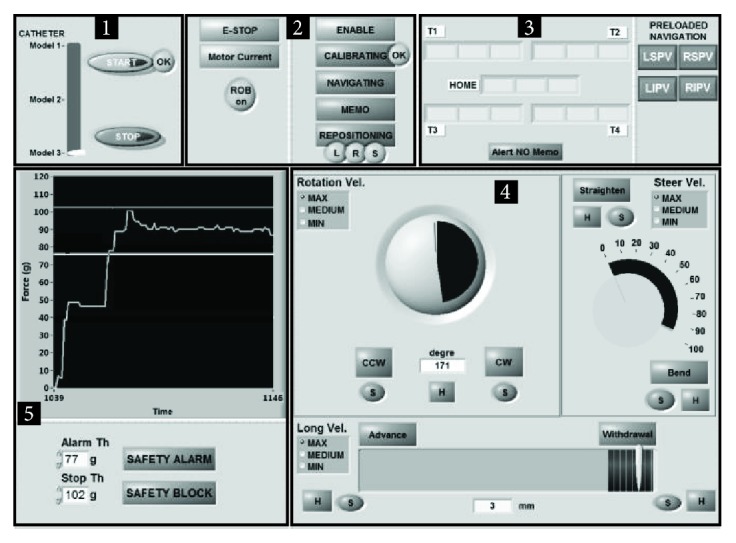
The CathROB GUI detailed in Table 2.